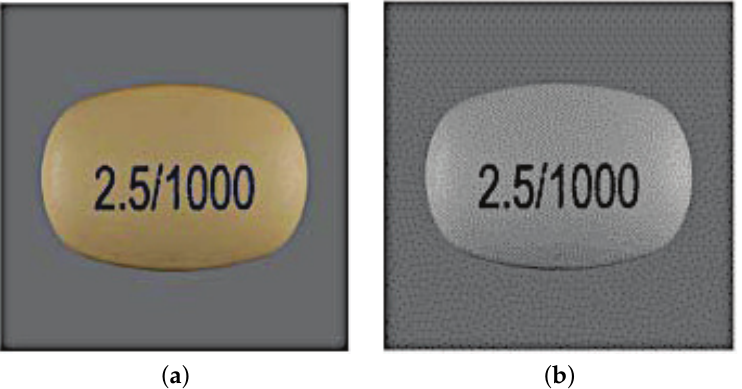
Figure 2. Colored vs. grayscale intensity pill image: ( a ) Raw input pill image; ( b ) pill image after grayscale conversion.